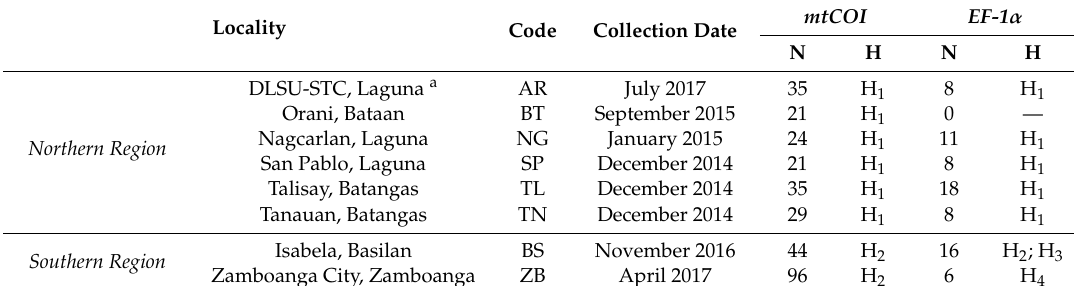
Table 1. Sampling localities of the outbreak A. rigidus populations. N, number of individuals with mtCOI and EF-1 α sequences; H, haplotypes indicated in Figure 3.